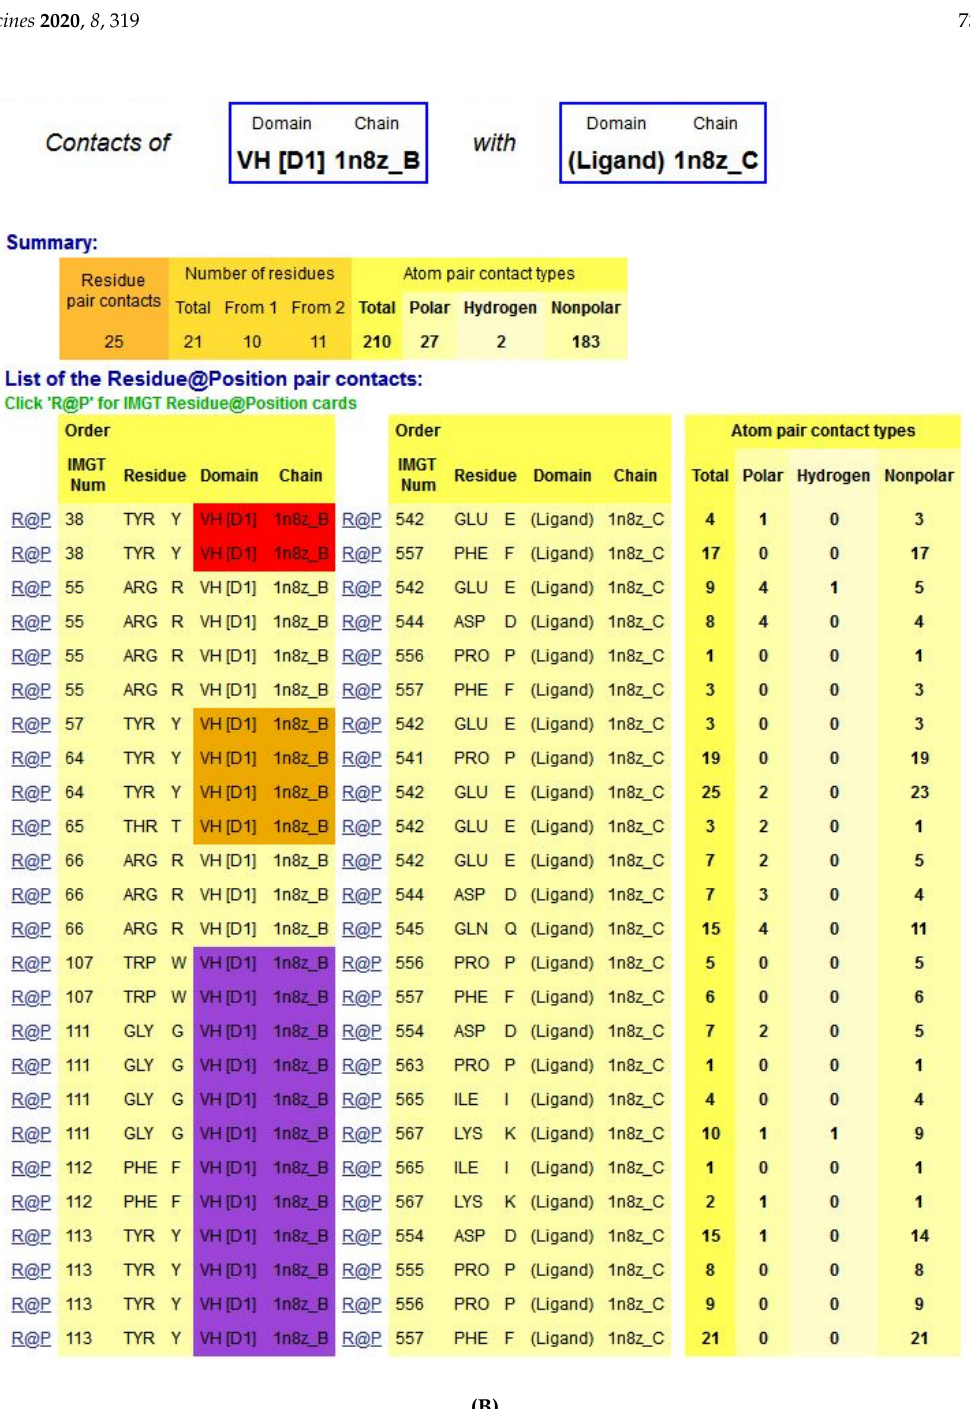
Figure 31. IMGT / 3Dstructure-DB Domain pair contacs [57–59]. ( A ). Domain pair contacts between Figure 31. IMGT/3Dstructure ‐ DB Domain pair contacs [57–59]. ( A ). Domain pair contacts between trastuzumab Fab V ‐ KAPPA (1n8z_A) and ERBB2 ((Ligand) 1n8z_C). ( B ). Domain pair contacts trastuzumab Fab V-KAPPA (1n8z_A) and ERBB2 ((Ligand) 1n8z_C). ( B ). Domain pair contacts between between trastuzumab Fab VH (1n8z_B) and ERBB2 ((Ligand) 1n8z_C). Positions in the CDR1 ‐ IMGT, trastuzumab Fab VH (1n8z_B) and ERBB2 ((Ligand) 1n8z_C). Positions in the CDR1-IMGT, CDR2-IMGT CDR2 ‐ IMGT and CDR3 ‐ IMGT are represented in blue, green and bluegreen, for the V ‐ KAPPA and in and CDR3-IMGT are represented in blue, green and bluegreen, for the V-KAPPA and in red, orange and red, orange and purple, for the VH. Positions in the FR ‐ IMGT are in yellow. 55 and 66 are anchors of purple, for the VH. Positions in the FR-IMGT are in yellow. 55 and 66 are anchors of the CDR2-IMGT. the CDR2 ‐ IMGT. Clicking on ‘R@P’ gives access to the IMGT Residue@Position card. (With Clicking on ‘R@P’ gives access to the IMGT Residue@Position card. (With permission from M-P. permission from M ‐ P. Lefranc and G. Lefranc, LIGM, Founders and Authors of IMGT ® , the Lefranc and G. Lefranc, LIGM, Founders and Authors of IMGT ® , the international ImMunoGeneTics international ImMunoGeneTics information system ® , http://www.imgt.org). information system ® , http: // ‘Renumbered IMGT flat file’ allows to view (or download) an IMGT coordinate file renumbered according to the IMGT unique numbering and to which has been added the IMGT specific